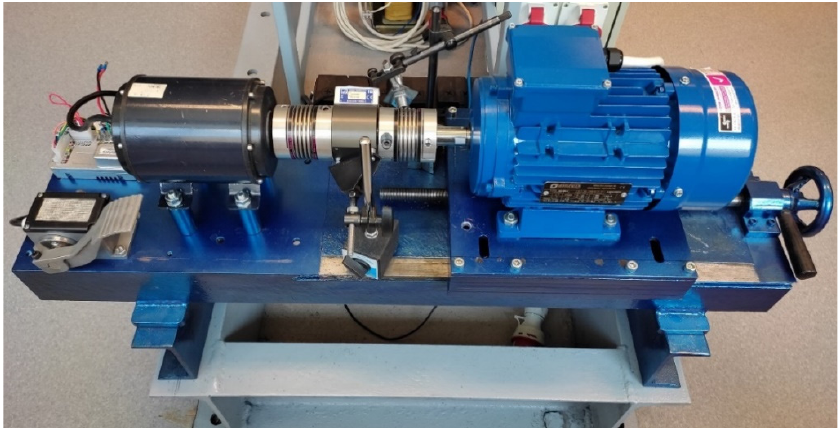
Figure 3. Photo of the test bench.